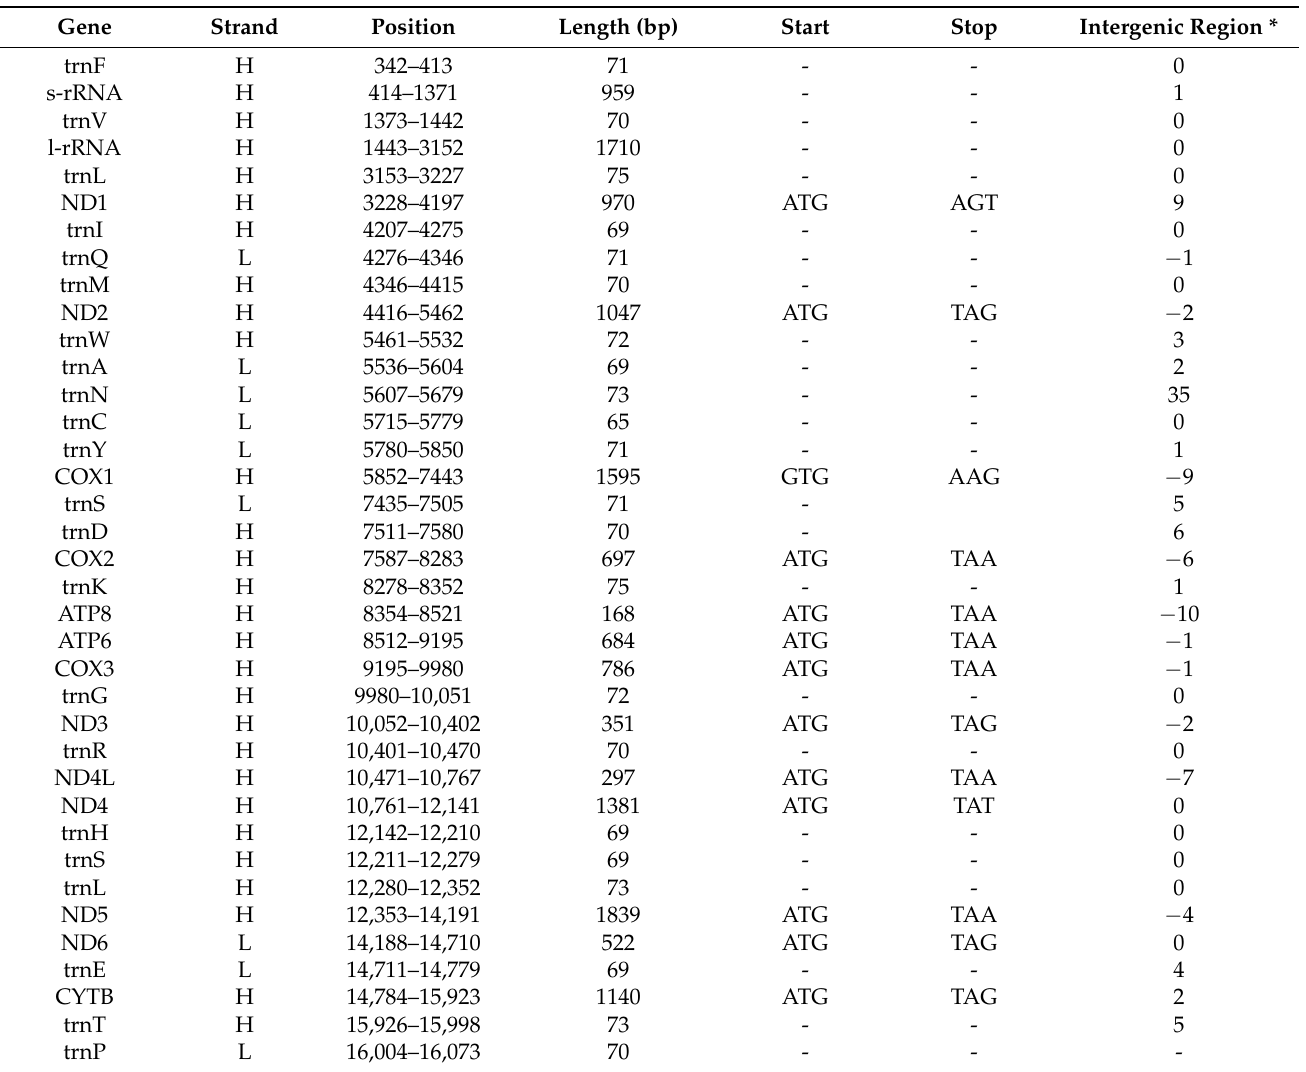
Table 2. Organization of the mitochondrial genome of S. affinis